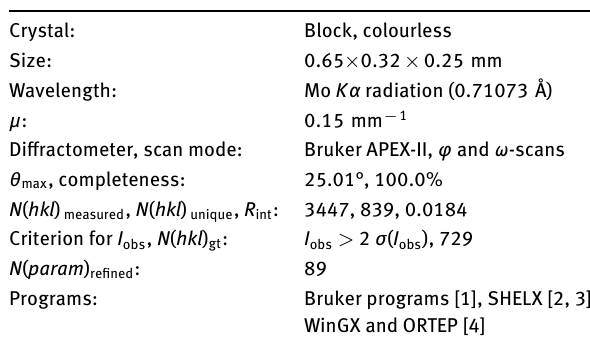
Table 1: Data collection and handling.